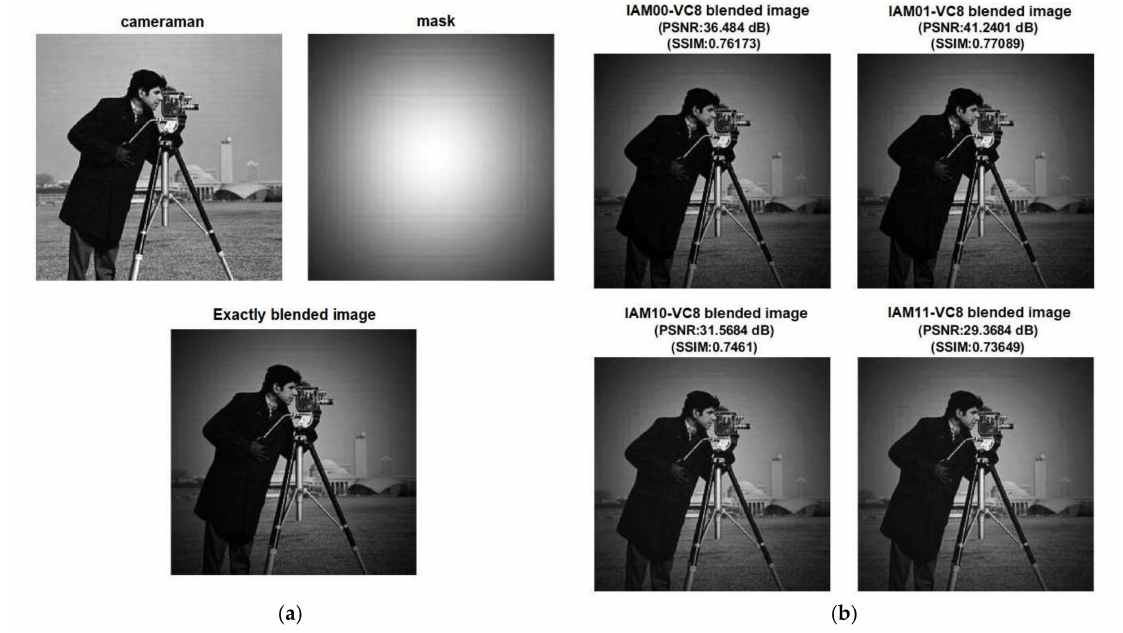
Figure 5. ( a ) Cameraman and mask images, and exactly blended image. ( b ) Blended images obtained using various inexact array multipliers (IAM00-VC8, IAM01-VC8, IAM10-VC8, and IAM11-VC8) based on vertical cut VC8 made on the exact array multiplier.